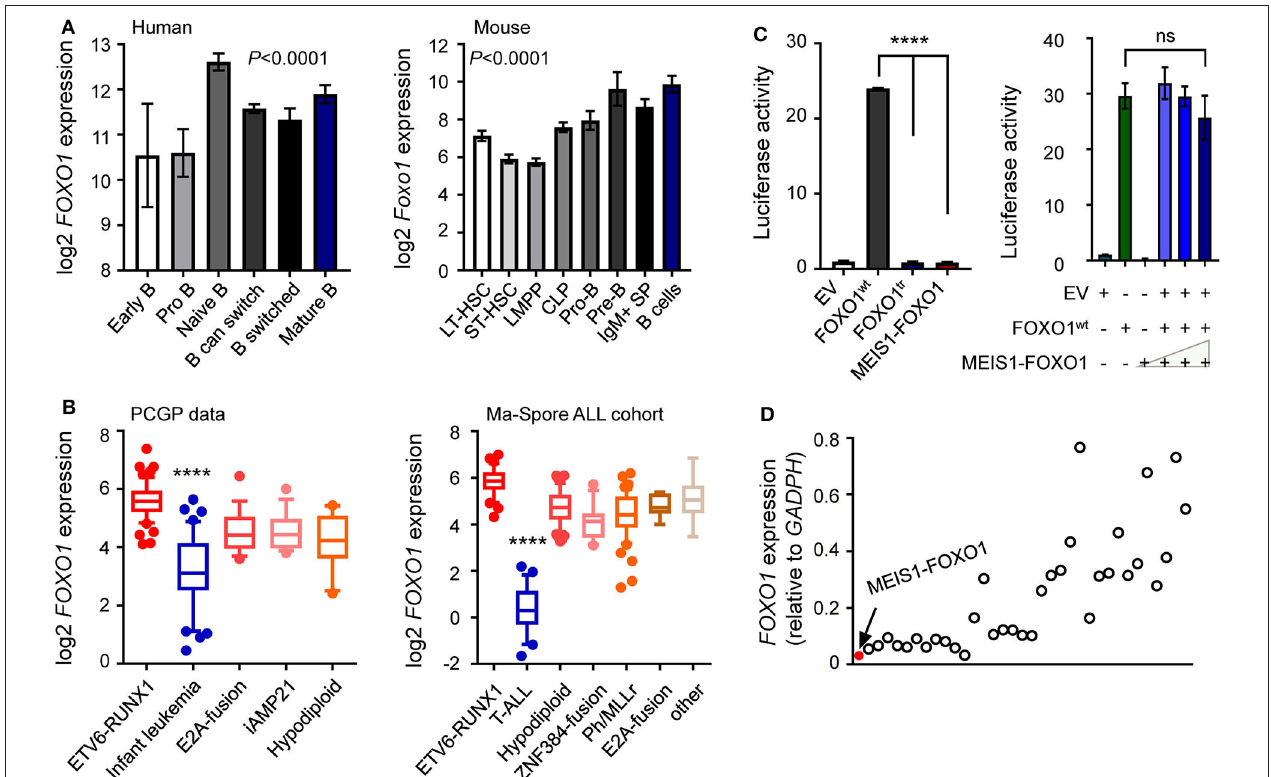
FIGURE 3 | Lower FOXO1 transcription associated with poor prognosis. (A) Expression of the FOXO1 was increased along with human (left panel) and mouse (right panel) B lymphocyte development. Each B-cell group is represented by a bar and is color-coded according to the subgroups it belongs to. (B) Expression of the FOXO1 was constitutively activated among B-ALL samples, with the highest expression in ETV6 - RUNX1 subtype. (C) Luciferase reporter gene assay of MEIS1–FOXO1 transcription activity. HEK-293T cells were transiently transfected with pGL3 construct (luciferase gene with FOXO1 binding sites), pcDNA construct [empty vector, wild-type FOXO1 [FOXO1 wt ], MEIS1–FOXO1, or truncated FOXO1 [FOXO1 tr ]], and pGL-TK (Renilla luciferase). (D) Expression of the FOXO1 among 35 B-ALL cases. RT-PCR was performed to quantify the FOXO1 transcription, and the quantification was expressed as relative to internal GAPDH control. The red dot represented the B-ALL case with MEIS1 – FOXO1 fusion gene. Statistical significance, determined using one-way ANOVA test (A,B) or two-sided unpaired t -test (C) , is indicated by **** P < 0.0001.